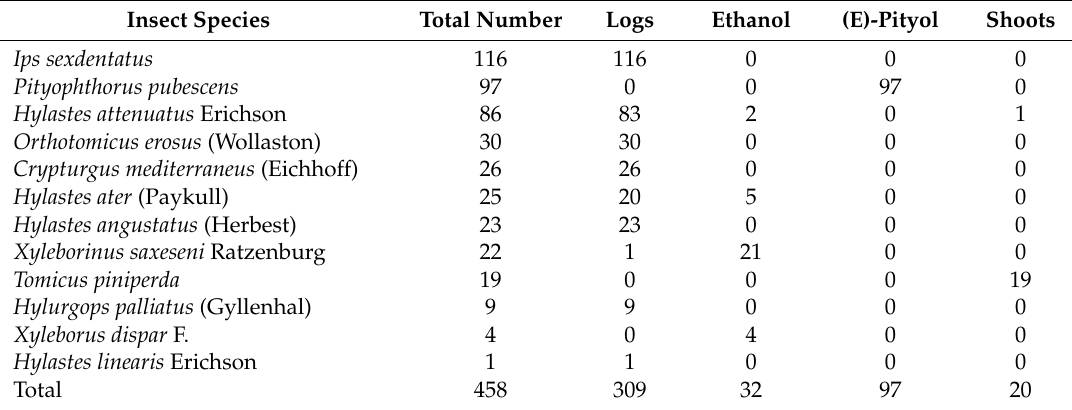
Table 1. Insect species collected from logs, funnel traps and